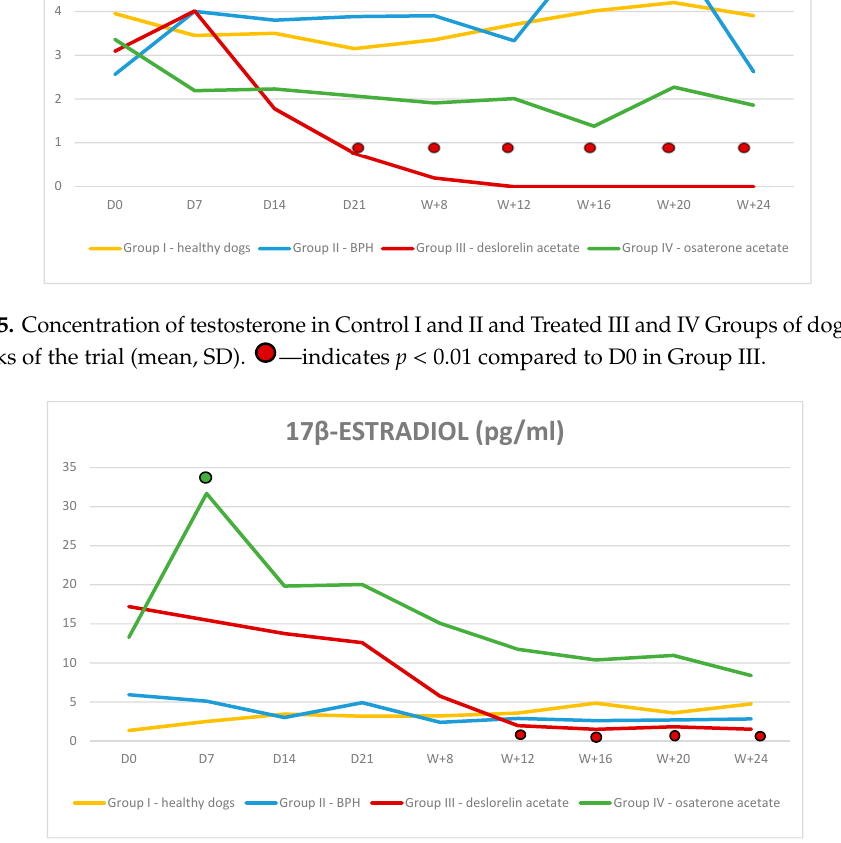
Figure 6. Concentration of 17 β -estradiol in Control I and II and Treated III and IV Groups of dogs during 24 weeks of the trial (mean, SD). —indicates p < 0.01 compared to D0.